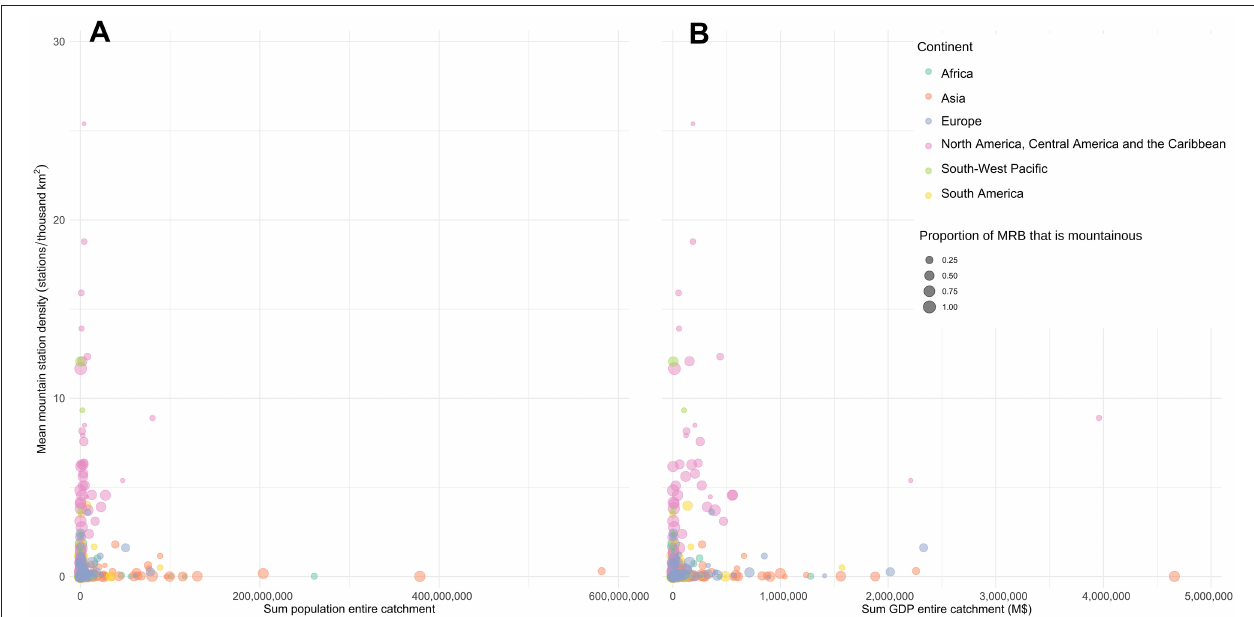
FIGURE 11 | Mean mountain GHCNd station density, irrespective of variable and record length, against the total human population of the associated downstream catchment (A) and the total Gross Domestic Product (GDP) of the associated downstream catchment (B) , for each Major River Basin